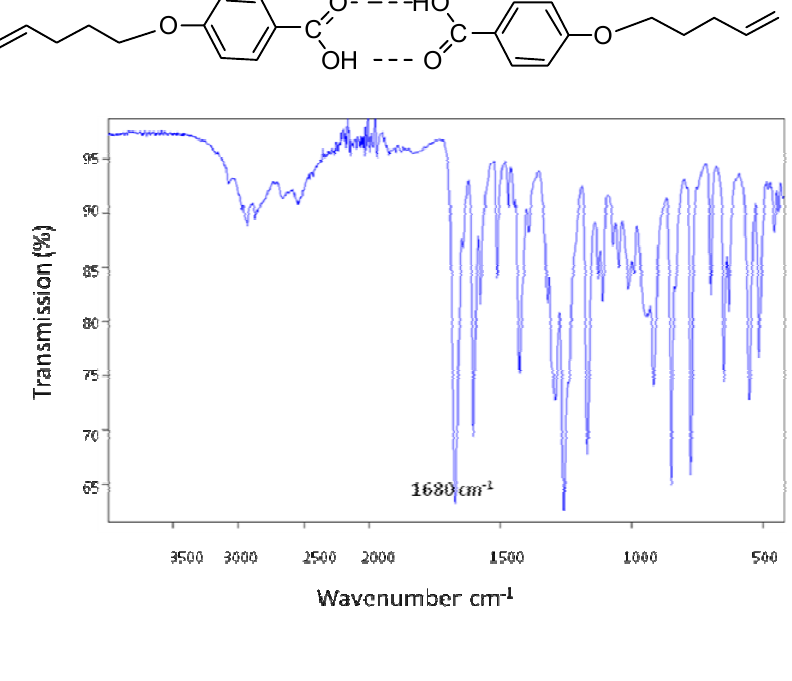
Figure 3. The proposed dimeric structure of 4-(4-pentenyloxy) benzoic acid; the spectrum indicates the presence of the carboxylic acid dimer; the carbonyl group in the proposed dimer structure has a characteristic band at 1680 cm -1